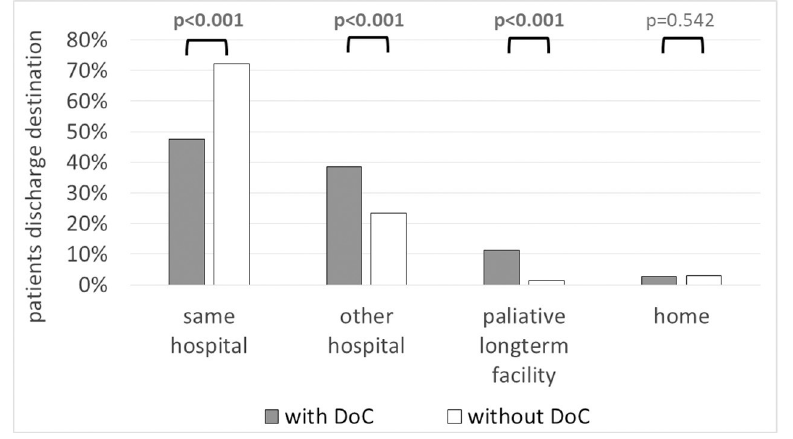
Fig 4. Discharge destinations among ICU patients who completed their ICU stay with and without DoC.